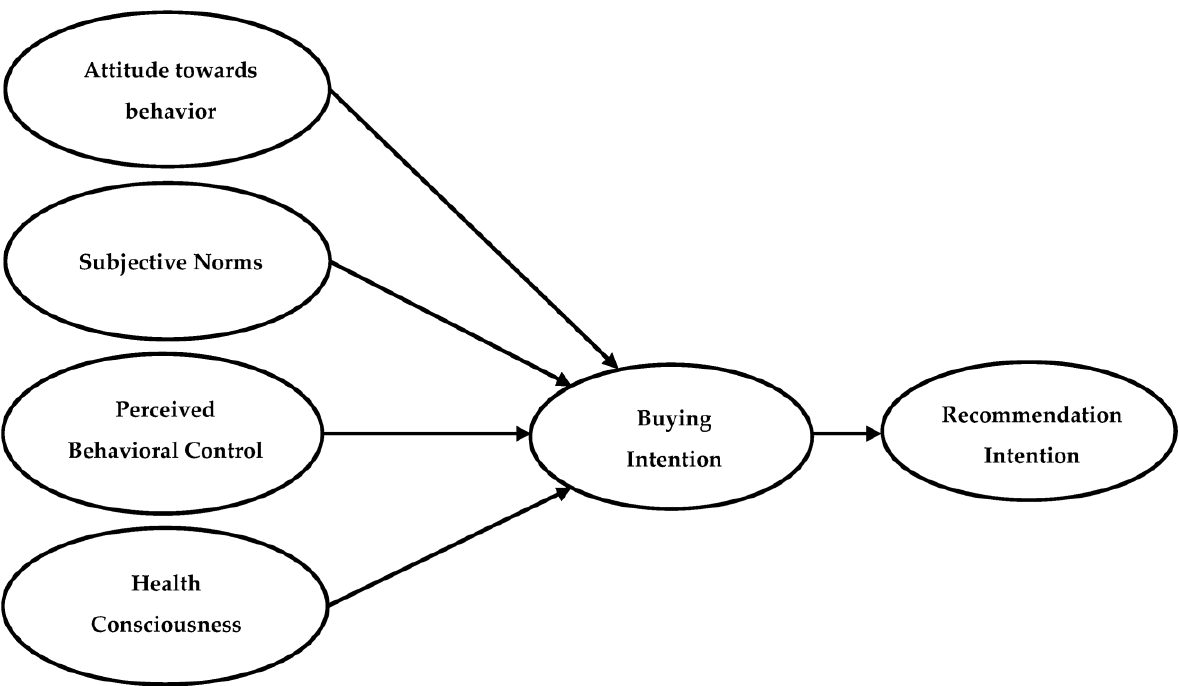
Figure 1. The research conceptual model.